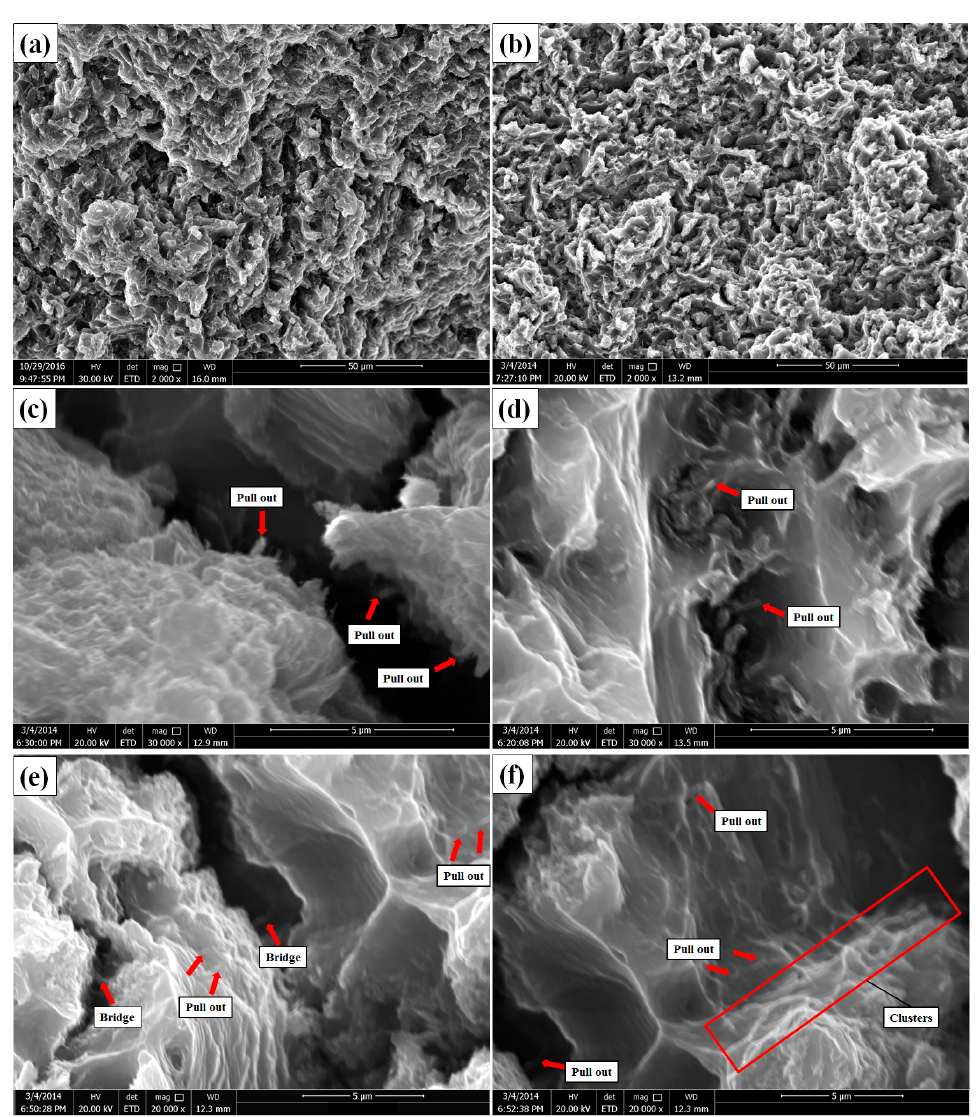
Figure 10. SEM images of the fracture surfaces of the as-extruded AZ31 composites and its nanocomposites: ( a ) AZ31, ( b ) AZ31-1.0 wt. % CNTs, ( c ) AZ31-0.5 wt. % CNTs, ( d ) AZ31-1.0 wt. % CNTs, ( e ) AZ31-2.0 wt. % CNTs and ( f ) AZ31-2.0 wt. % CNTs (( a , b ) are low magnification images, and ( c – f ) are high magnification images).